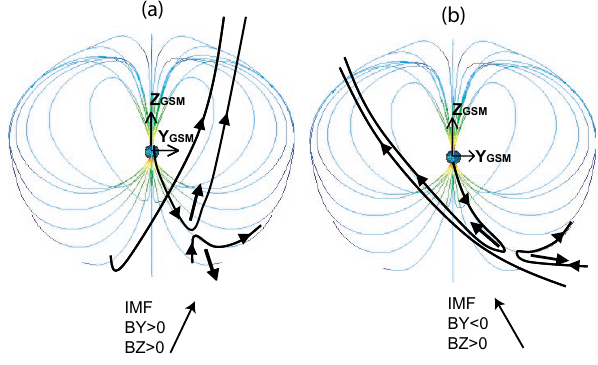
Fig. 9. Reconnection configuration for the two orientations of IMF. (a) IMF B Z > 0, B Y > 0, (b) IMF B Z > 0, B Y < 0. The jet directions are represented by the